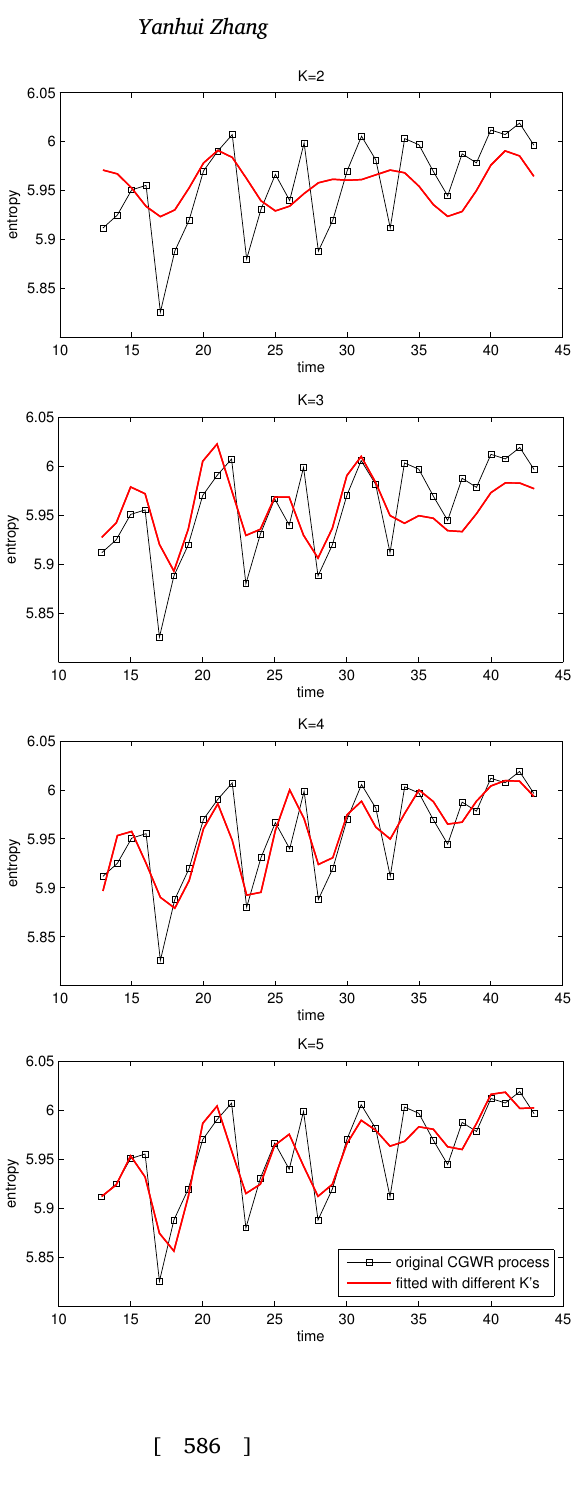
Figure 5: Plot of the steady state series and the fitted curves using trigonometric functions with K=2, 3, 4,